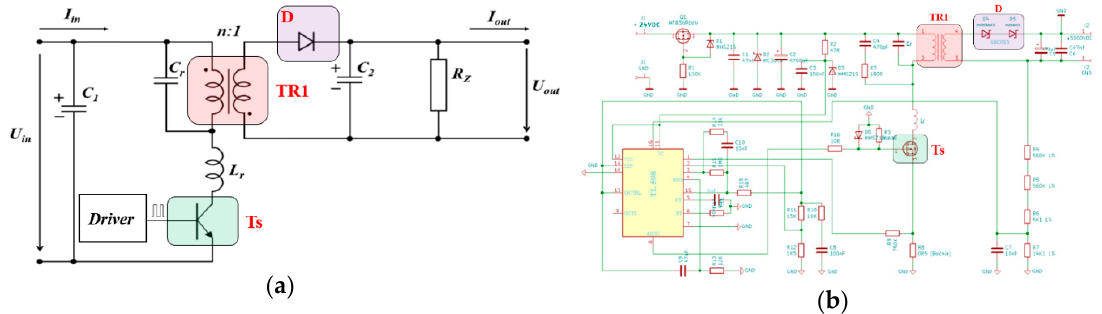
Figure 23. Schematics of the new magnetron power supply ( a ) the Flayback resonant converter (ZCS); ( b ) the constructed resonant converter.